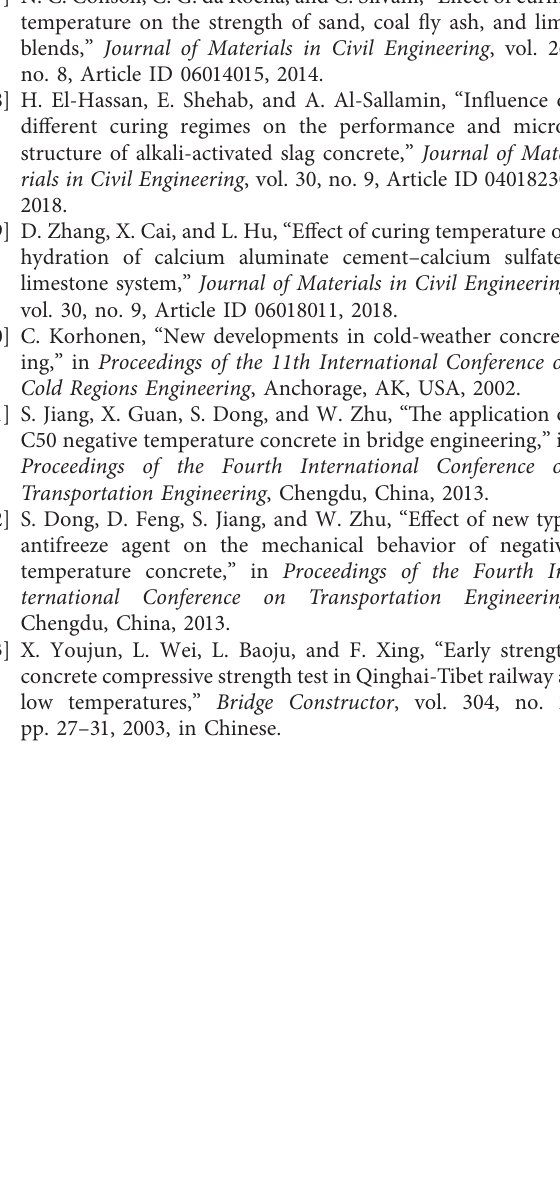
Figure 11: concrete strain analysis. Figure 12: concrete hy- dration temperature analysis. ( Supplementary Materials